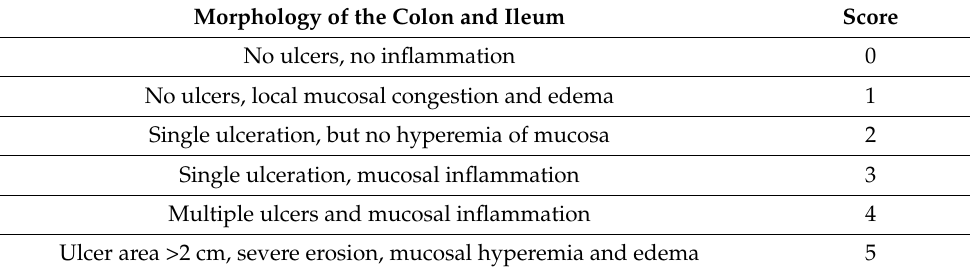
Table 1. Scoring criteria for macroscopic observation of colon and ileum. Morphology of the Colon and Ileum Score No ulcers, no inflammation 0 No ulcers, local mucosal congestion and edema 1 Single ulceration, but no hyperemia of mucosa 2 Single ulceration, mucosal inflammation 3 Multiple ulcers and mucosal inflammation 4 Ulcer area >2 cm, severe erosion, mucosal hyperemia and edema 5 Table 2. Histopathological scoring criteria of ileum and colon. Histopathological Manifestations of the Ileum and Colon Score No obvious inflammation reaction 0 Low-level inflammatory cell infiltration, no damage to intestinal villi structure 1 Moderate inflammatory cell infiltration, deepening of the intestinal crypts, thickening of the intestinal wall but not invading the muscle layer High levels of inflammatory cell infiltration, vascular proliferation, thickening of the intestinal wall and invasion of the muscle layer Infiltration of inflammatory cells, reduction in goblet cells, vascular